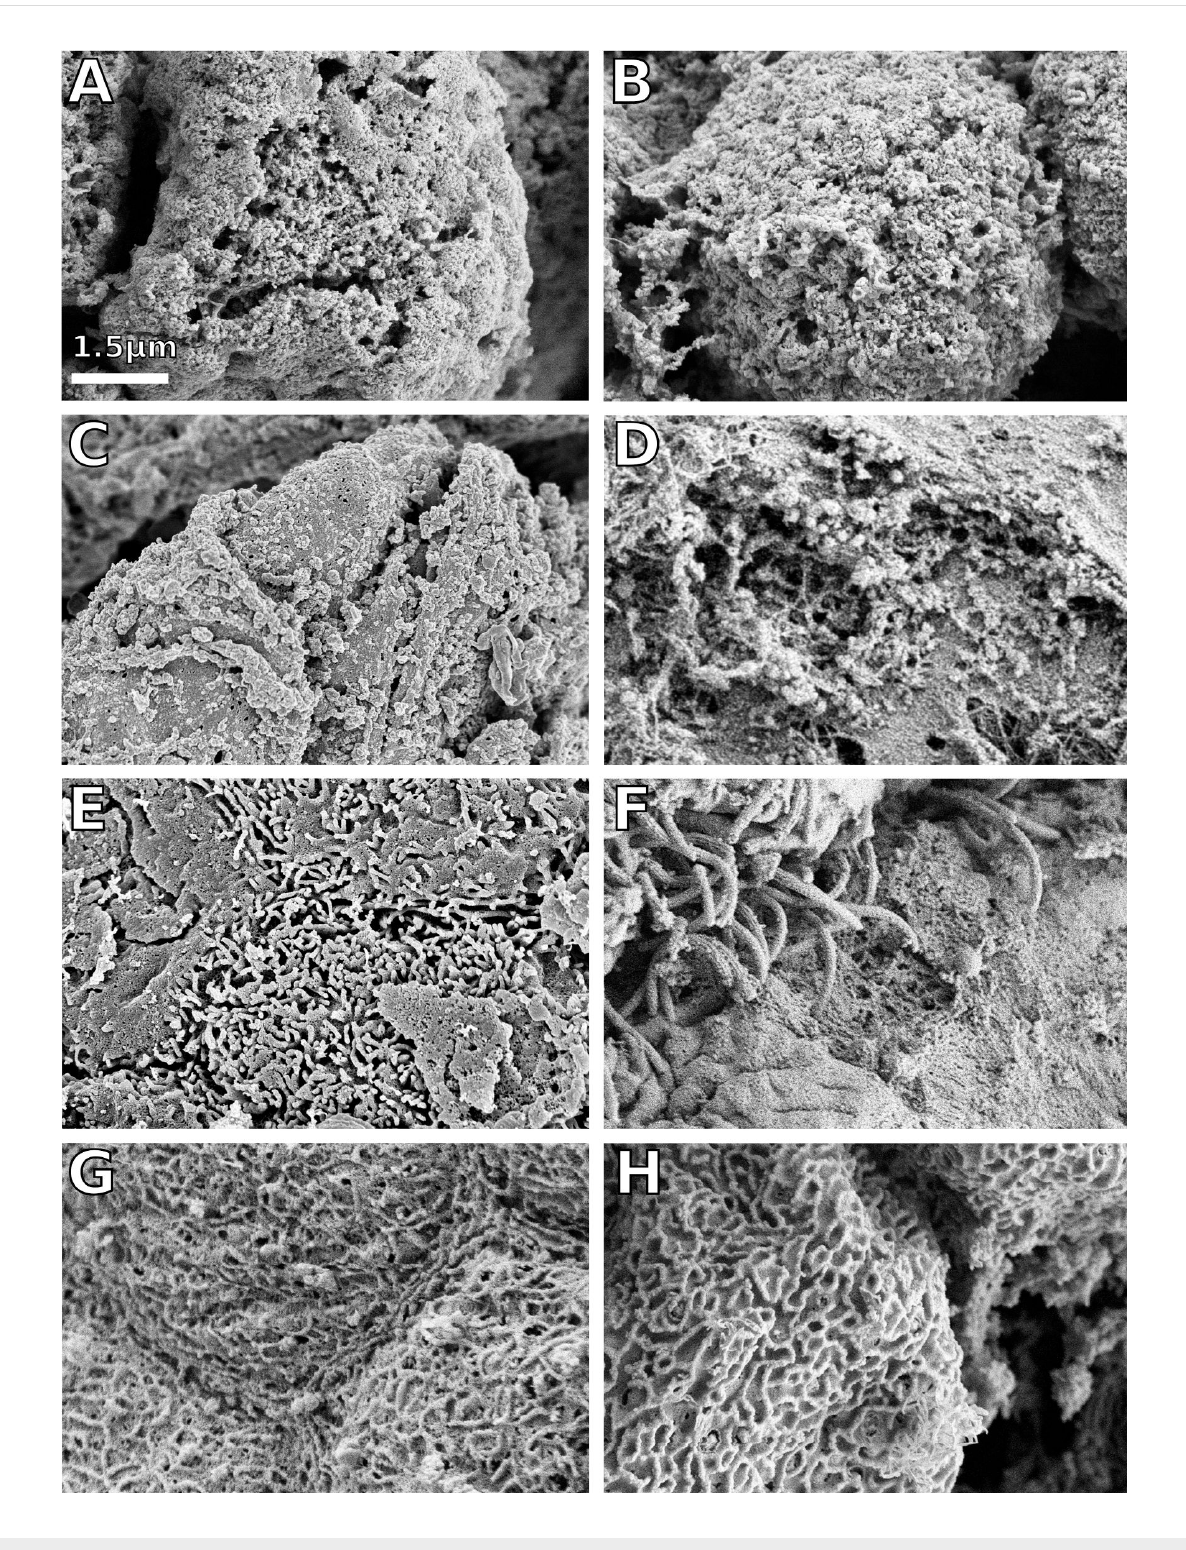
Figure 2: Scanning electron microscopy of the filiform papillae on frog tongues. All images are at the same scale. A – Bombina variegata , B – Discoglossus pictus , C – Ceratophrys ornata , D – Litoria infrafrenata , E – Megophrys nasuta , F – Rana ( Lithobates) pipiens , G – Bufo bufo , H – Oophaga histrionica . The filiform papillae show a remarkable degree of interspecific variation. In M. nasuta (E) and R. pipiens (F), we found hair- like outgrowths on the filiform papillae; in B. bufo (G) and O. histrionica (F), the filiform papillae are covered by